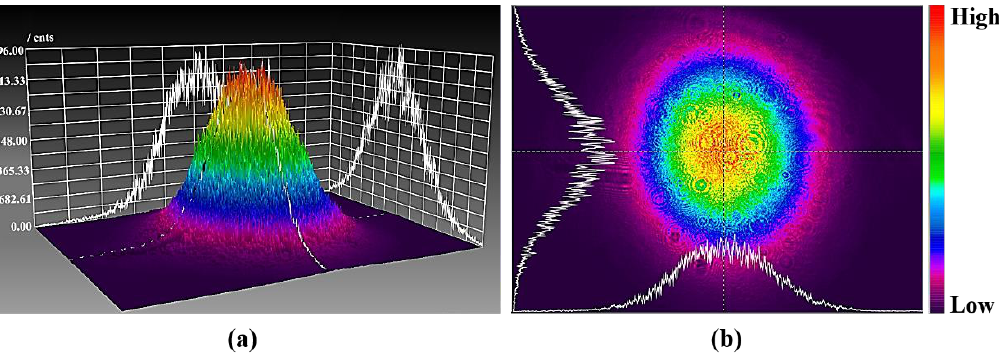
Figure 4. The schematic diagram of energy density distribution of femtosecond laser beam. ( a ) The 3D energy density distribution and ( b ) the 2D energy density distribution.